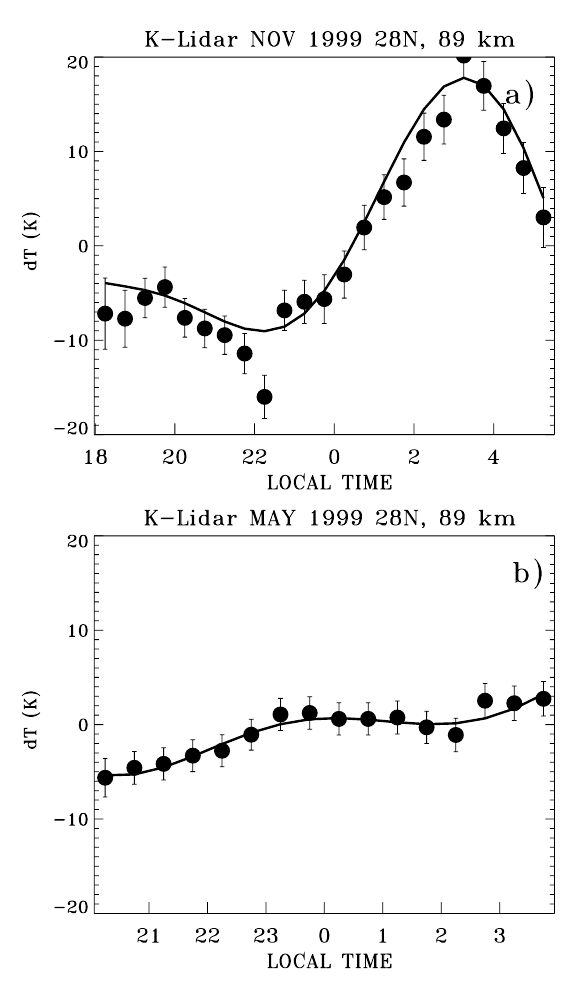
Fig. 4. Potassium lidar temperature semidiurnal and terdiurnal tidal fits at 28 ◦ N for the months of November (a) and May (b) ,